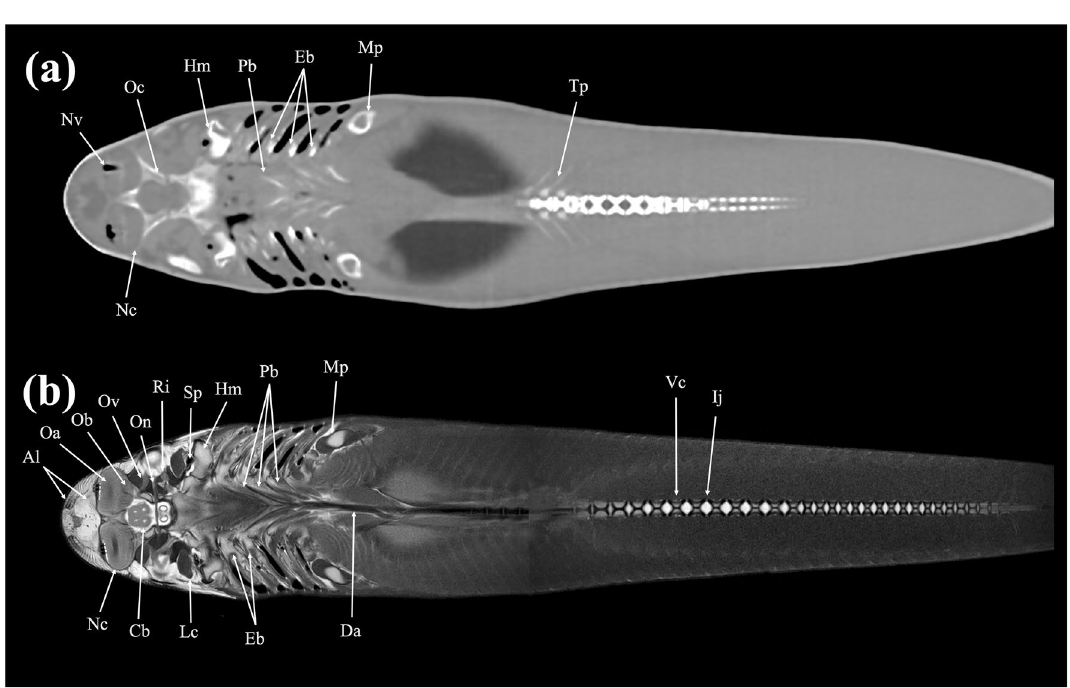
Figure 21. Dorsal ( a ) CT and ( b ) MR images of a banded houndshark ( Triakis scyllium ) at level 21 of Fig. 25. Al Ampullae of Lorenzini, Cb Cerebrum; Da Dorsal aorta, Eb Epibranchial, Hm Hyomandibular, Ij Intervertebral junction, Lc Levator cranium maxillae, Mp Metapterygium, Nc Nasal capsule, Nv Nasal cavity, Oa Olfactory lamellae, Ob Olfactory bulb, Oc Optic capsule, On Optic nerve, Ov Obliquus ventralis, Pb Pharyngobranchial, Tp Transverse process, Ri Rectus inferior, Sp Spiracle, Vc Vertebral